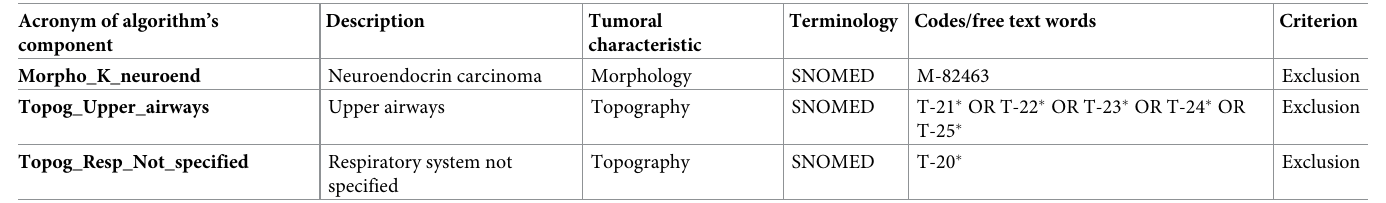
Table 2. Additional algorithm components used for algorithm